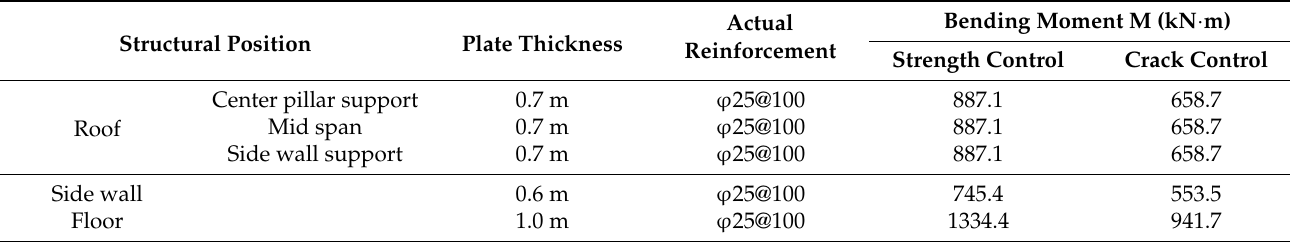
Table 7. Transverse carrying capacity of existing stations.